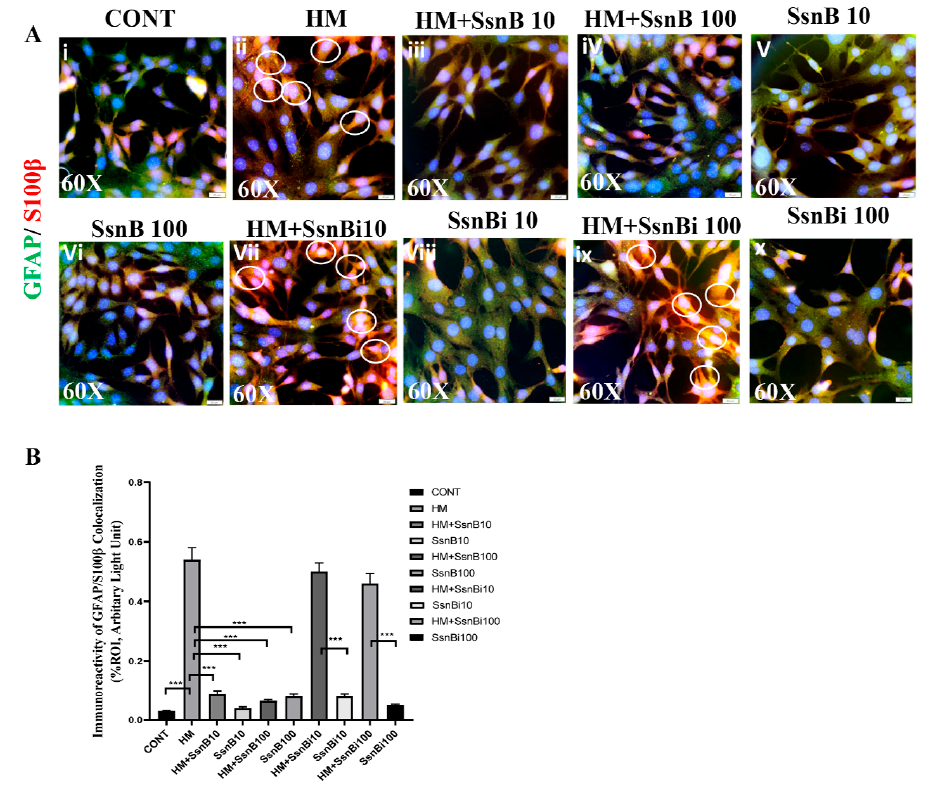
Figure 8. SsnB reduces HMGB1 induced expression of inflammatory markers GFAP / S100B in mouse primary astrocytes. Mouse primary astrocyte cells were treated with HMGB1(HM), HMGB1 with SsnB at 10 µ g / mL (HM + SsnB10) and 100 µ g / mL (HM + SsnB100) concentrations and only SsnB at 10 µ g / mL (SsnB10) and 100 µ g / mL (SsnB100) concentrations. The cells were also treated with inactivated or pseudo-SsnB along with HMGB1 at 10 µ g / mL (HM + SsnBi10) and 100 µ g / mL (HM + SsniB100) concentrations. Inactivated SsnB at the two concentrations (SsnBi10 and SsnBi100, respectively) were used as controls to compare with HM + SsnBi10 and HM + SsniB100. Immunofluorescence microscopy was used to study the inflammation induced by HMGB1 by dual-labeling the cells with S100B (red) / GFAP (green). Colocalizations were observed in the cytoplasmic region of the cells as yellow dots and are marked in the representative images by white circles (Figure 8A). Images were taken at 60 × magnification. Bar graphs depicting morphometric analysis ofS100B / GFAP (Figure 8B) colocalizations are represented as mean ± SD of the %ROI (mean value calculated from three separate fields of a section). Significance was analyzed by unpaired T-test where ** p < 0.01, *** p <